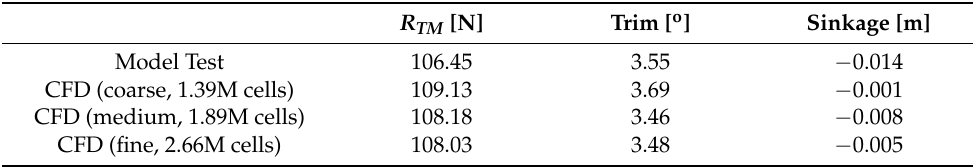
Table 2. Model test and CFD results of the initial hull form at design speed.